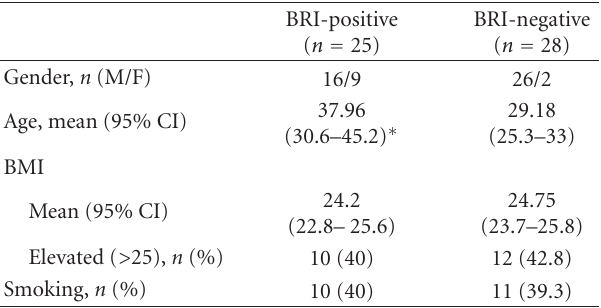
Table 3: Demographic and clinical data in BRI-positive and BRI- negative GERD